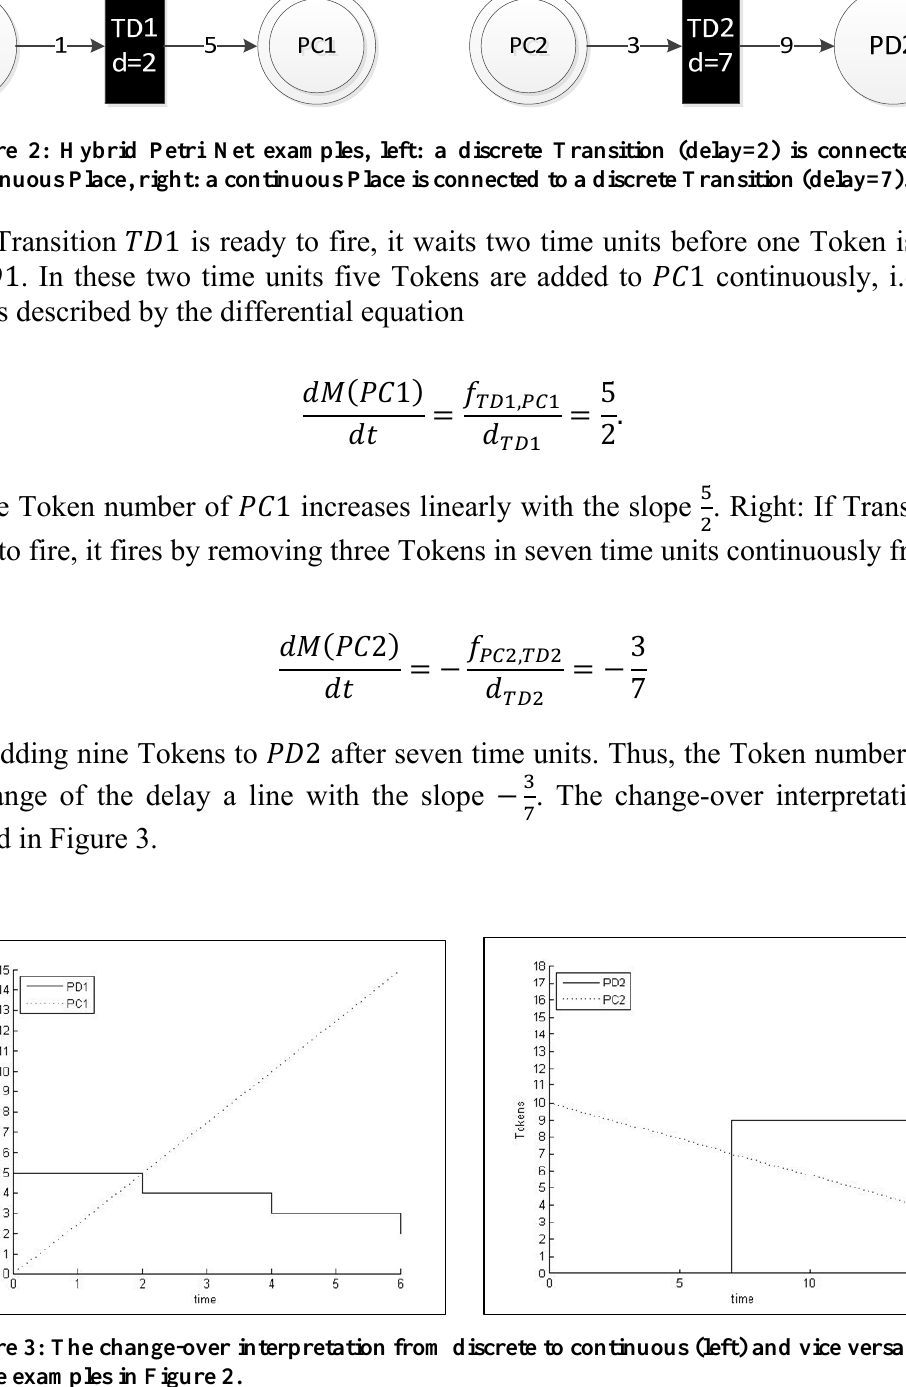
Figure 2: Hybrid Petri Net examples, left: a discrete Transition continuous Place, right: a continuous Place is connected to a